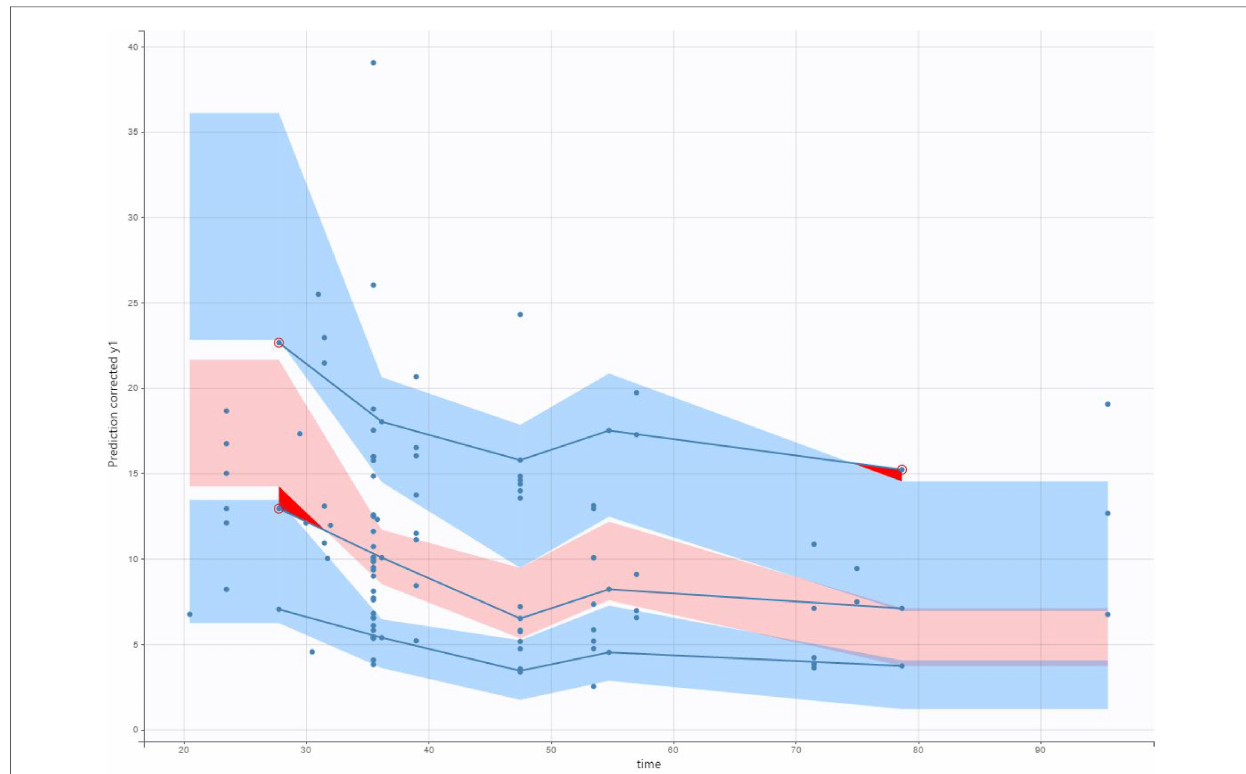
FIGURE 5 Visual predictive check (VPC) of our fi nal model applied to the validation data set. The solid lines represent the 10th, 50th and 90th percentiles of observed data. The shaded regions represent the 90% con fi dence interval around the 10th, 50th and 90th percentiles of simulated data. The circles are observed